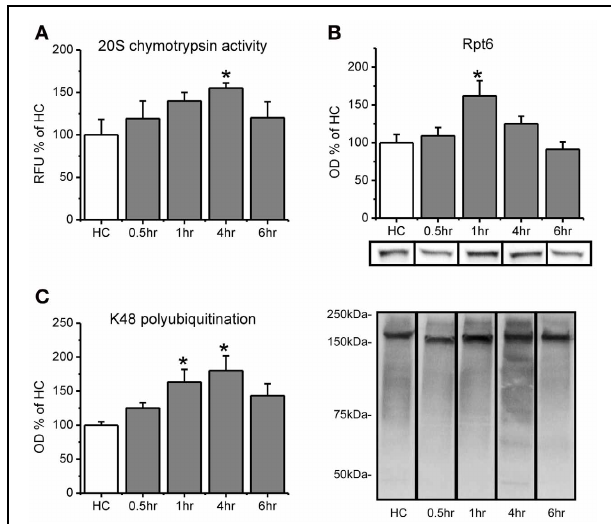
FIGURE 1 | Proteasome chymotrypsin-like activity is increased in the amygdala after fear conditioning. Rats were trained to auditory fear conditioning ( n = 10–11 per group) and amygdala tissue collected 0.5, 1, 4, or 6h later for in vitro proteasome activity assay and Western blotting. (A) Amygdala lysates collected 4h after fear conditioning showed enhanced degradation of the fluorogenic substrate LLVY-AMC relative to homecage (HC) controls. (B) There were transient increases in proteasome subunit Rpt6 that returned to baseline levels by 4h. (C) Lysine-48 linked polyubiquitination was increased from 1–4h after fear conditioning. Lower right panel shows representative K48 polyubiquitin blots for each group from the same gel. ∗ p < 0 . 05 from HC